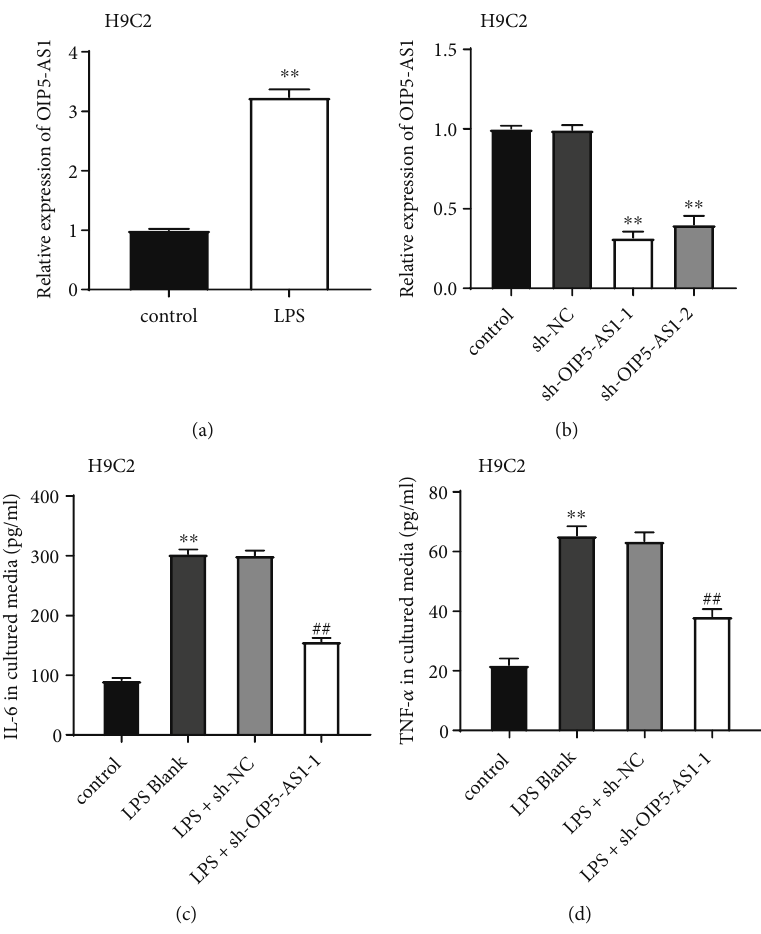
Figure 3: Knockdown of OIP5-AS1 inhibits in fl ammation in LPS-treated H9C2 cells. (a) Relative expression of OIP5-AS1 in LPS-treated H9C2 cells was determined by qRT-PCR. ** P < 0 : 01 versus control. (b) Relative expression of OIP5-AS1 in H9C2 cells transfected with sh-OIP5-AS1 was determined by qRT-PCR. ** P < 0 : 01 versus control. (c and d) The levels of IL-6 and TNF- α in culture supernatants of LPS-treated H9C2 cells were measured by ELISA. ** P < 0 : 01 versu s control. ## P < 0 : 01 versu s